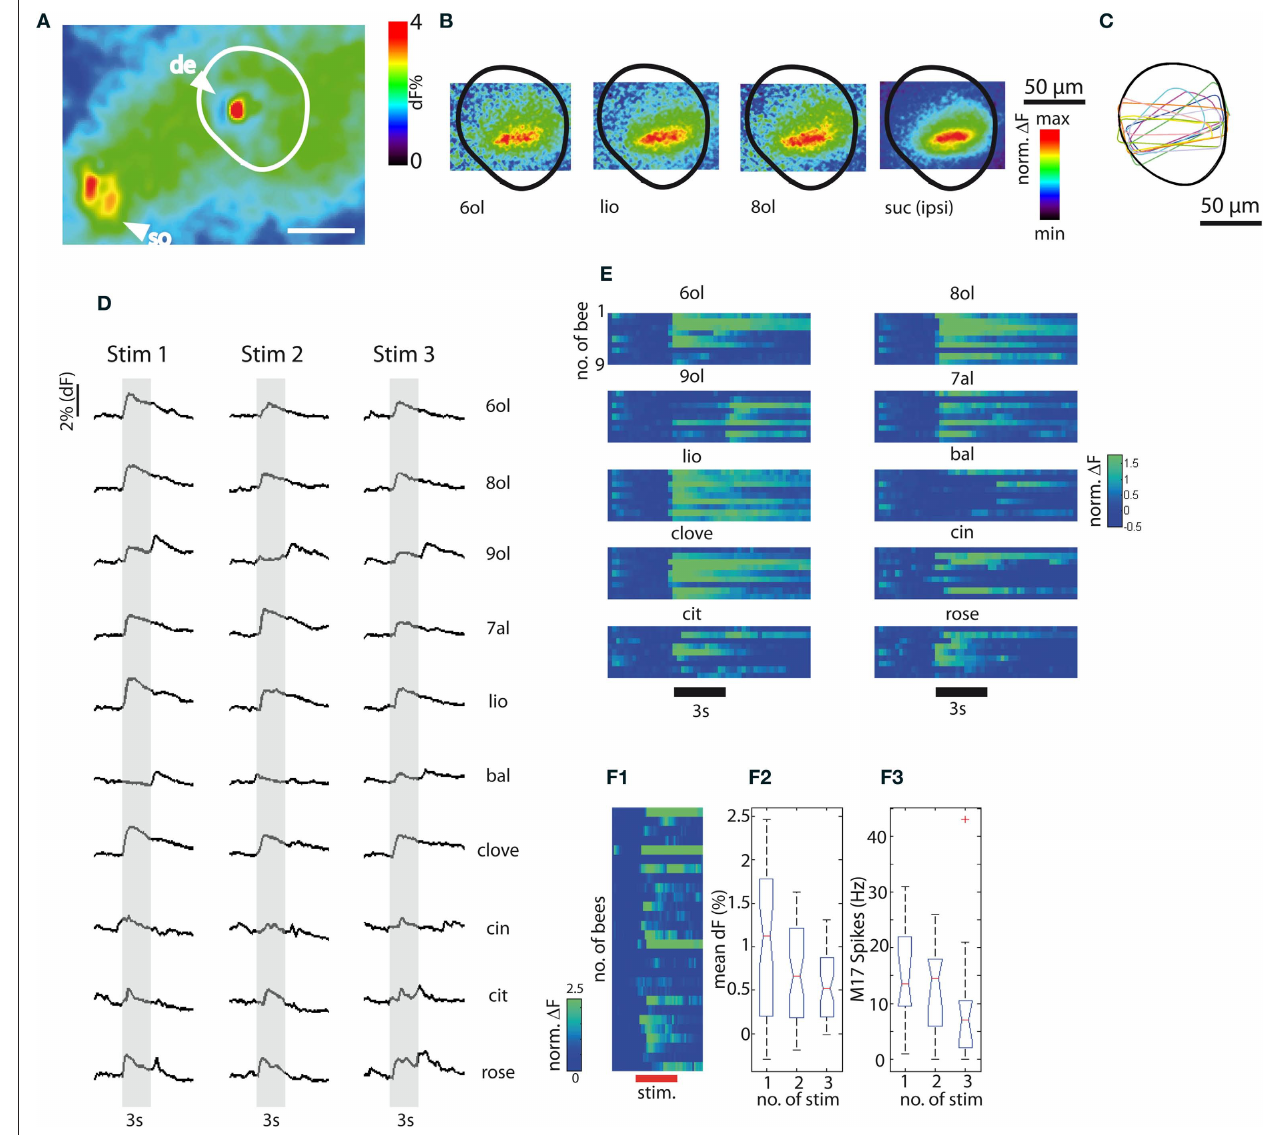
dynamics of Ca 2 + signals in response to ten odors in nine bees (responses in the first column of (D) correspond to the sixth row for each odor. (F1) Sucrose responses recorded in PCT neurons in the median α L of 28 bees. (F2) Mean response amplitudes during repetitive stimulation (three times) with sucrose solution. A significant decrease is found between trials ( n = 28, One-Way ANOVA: df = 2, F = 10.06, p ≤ 0.001). (F3) Quantification of behavioral responses to sucrose stimulation by M17 electromyographic recordings: mean spike frequencies during stimulus presentation for three repeated trials. The trend for decreased number of spikes is not significant ( n = 11, One-Way ANOVA, df = 2, F = 1.78, p =